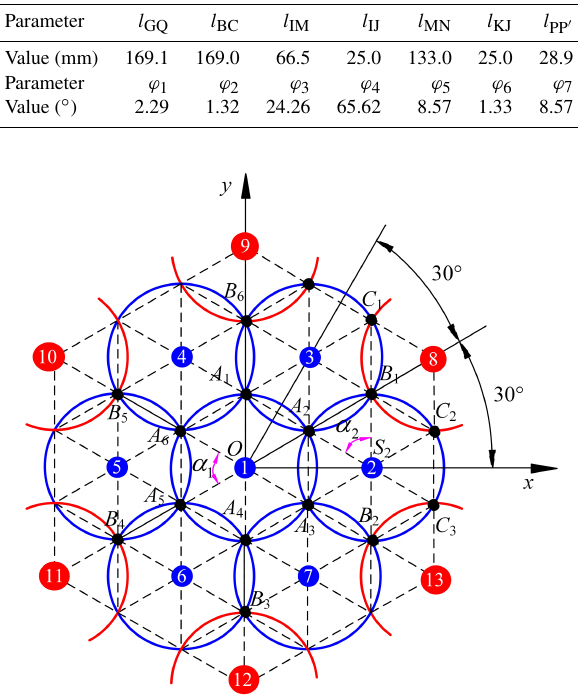
Figure 8. Top view of the space equal envelope